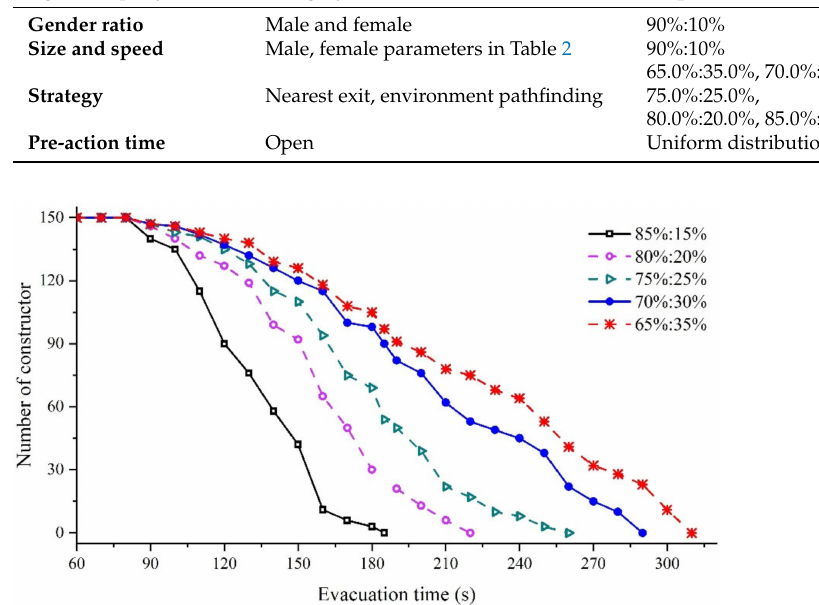
Figure 11. Evacuation process of constructors with different occupational age